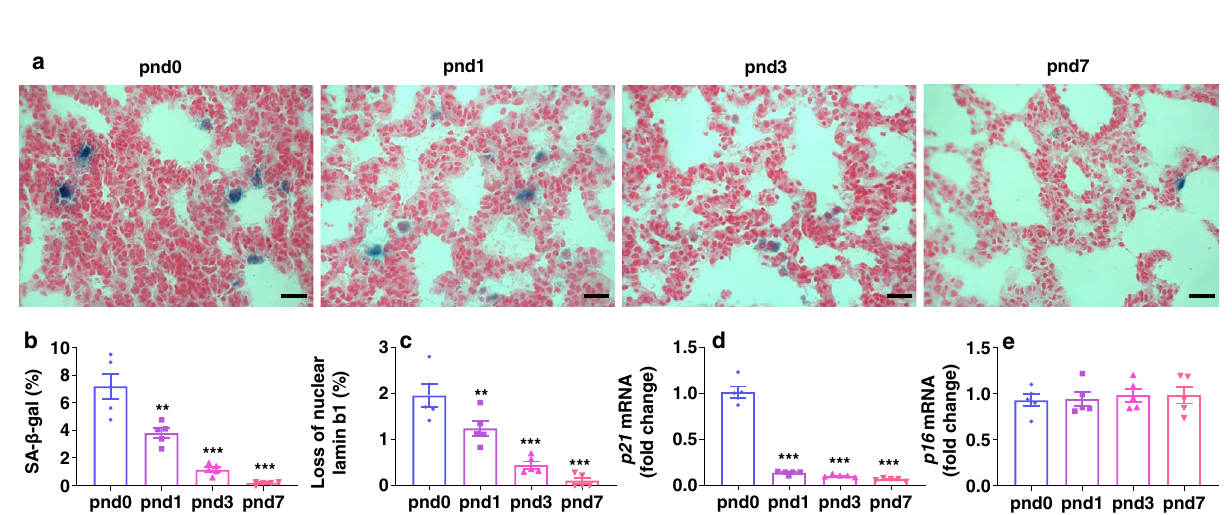
Fig. 9 | Lung senescence occurs in newborn mice, and this graduallydecreases duringthesaccularstageoflungdevelopment. LungwascollectedfromC57BL/ 6J mice at pnd0, pnd1, pnd3 and pnd7 under normoxia. a – c SA- β -gal activity and lamin b1 staining were performed in the lung. d , e qRT-PCR was carried out to